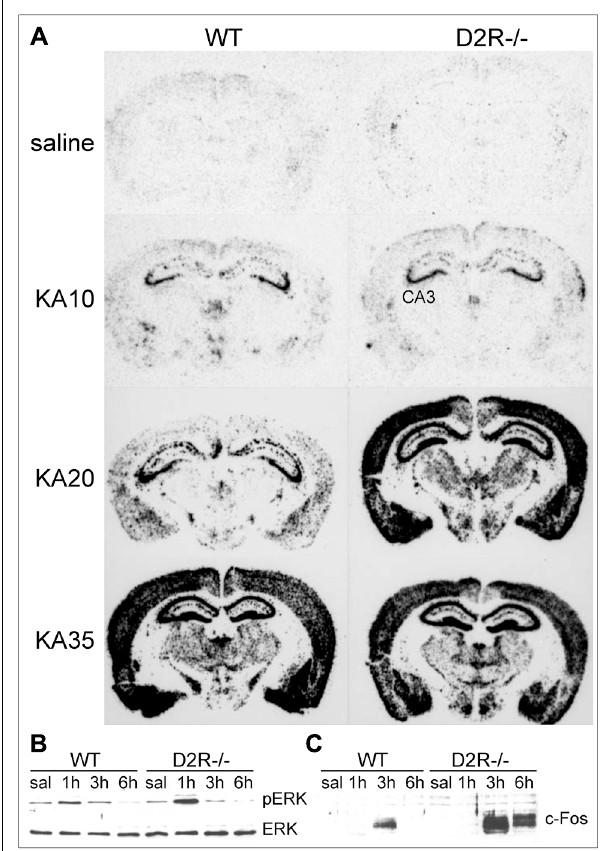
FIGURE 2 | D2R signaling pathways activated in response to seizures. (A) Pattern of c- fos mRNA induction (dark staining) in the brain ofWT and D2R − / − mice treated with 10, 20, and 35 mg/kg kainic acid (KA), as indicated. Brains were dissected 3 h after KA administration and coronal sections were processed by mRNA in situ hybridization with a c- fos specific anti-sense riboprobe (see Bozzi etal., 2000 for experimental details). Administration of 20 mg/kg KA induced limbic motor seizures in D2R − / − but notWT mice (Bozzi etal., 2000;Tripathi etal., 2010; Dunleavy etal., 2013), whereas generalized seizures were observed in both genotypes at 35 mg/kg KA (Bozzi etal., 2000). (B,C) Induction of ERK phosphorylation (pERK) and c-Fos protein synthesis in the hippocampus of WT and D2R − / − mice following KA-induced seizures. Mice received a single systemic dose of KA (20 mg/kg) and ERK/pERK (B) and c-Fos (C) induction were analyzed by immunoblotting on total hippocampal protein extracts at different times after KA (1, 3, and 6 h, as indicated). CA3, pyramidal cell layer of the hippocampus; D2R − / − , D2R knockout mice; KA, kainic acid; (p)ERK, (phosphorylated) extracellular-regulated kinase; saline, saline-treated mice;WT, wild-type